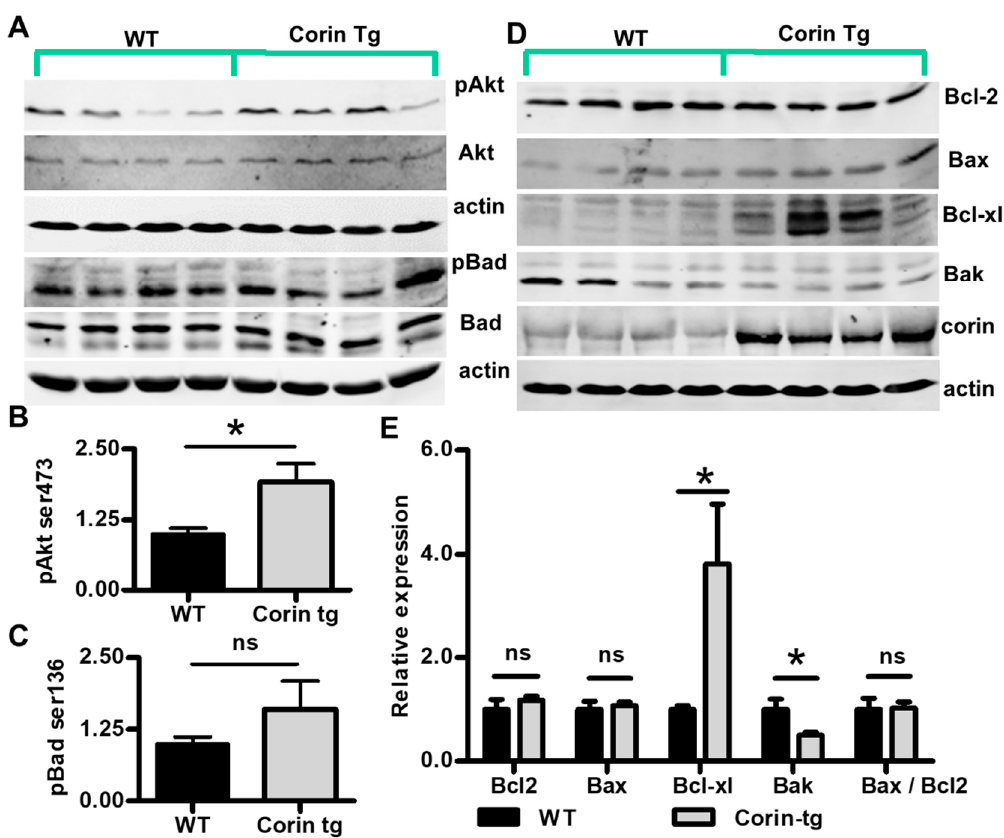
Figure 5. Corin overexpression regulates expression of the Bcl-2 family of proteins expression in non-MI hearts. ( A ) Expression of Akt and Bad, as well as Akt phosphorylation (Ser473) and Bad phosphorylation (Ser136) were assessed by Western-blot under reduced conditions in corin-Tg